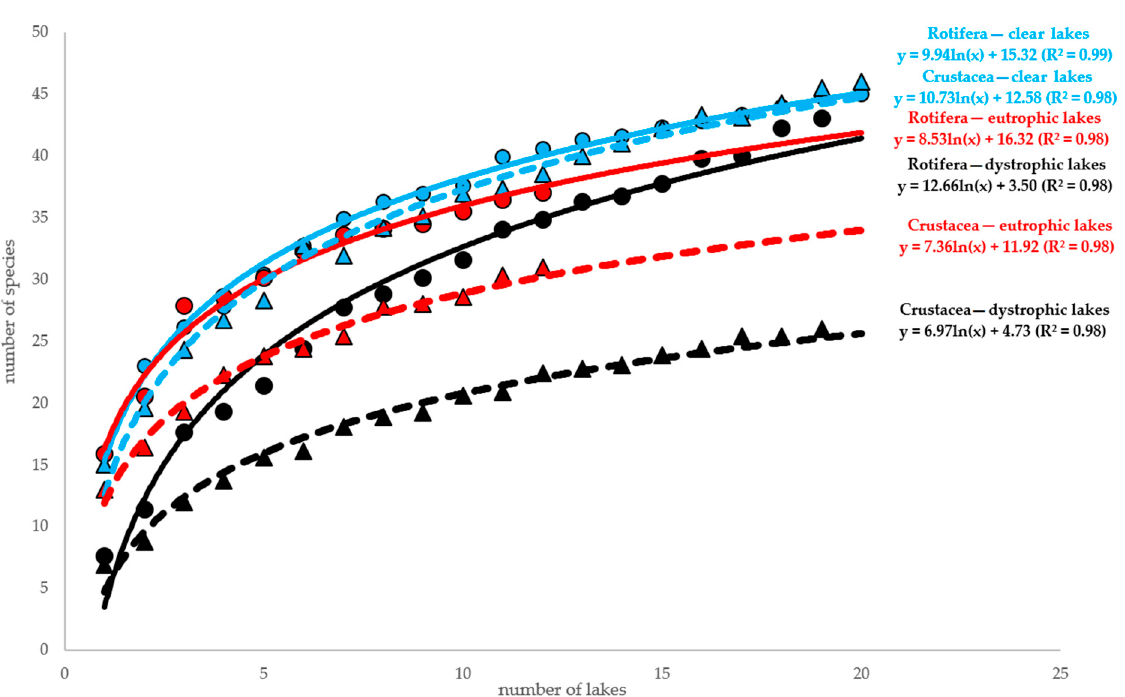
Figure 3. The relationship between the number of samples (=lakes) and the number of species calculated with 10 ran- domizations of sampling order. Clear lakes represent oligotrophic and mesotrophic conditions; circles represent Rotifera, tri- angles—Crustacea.